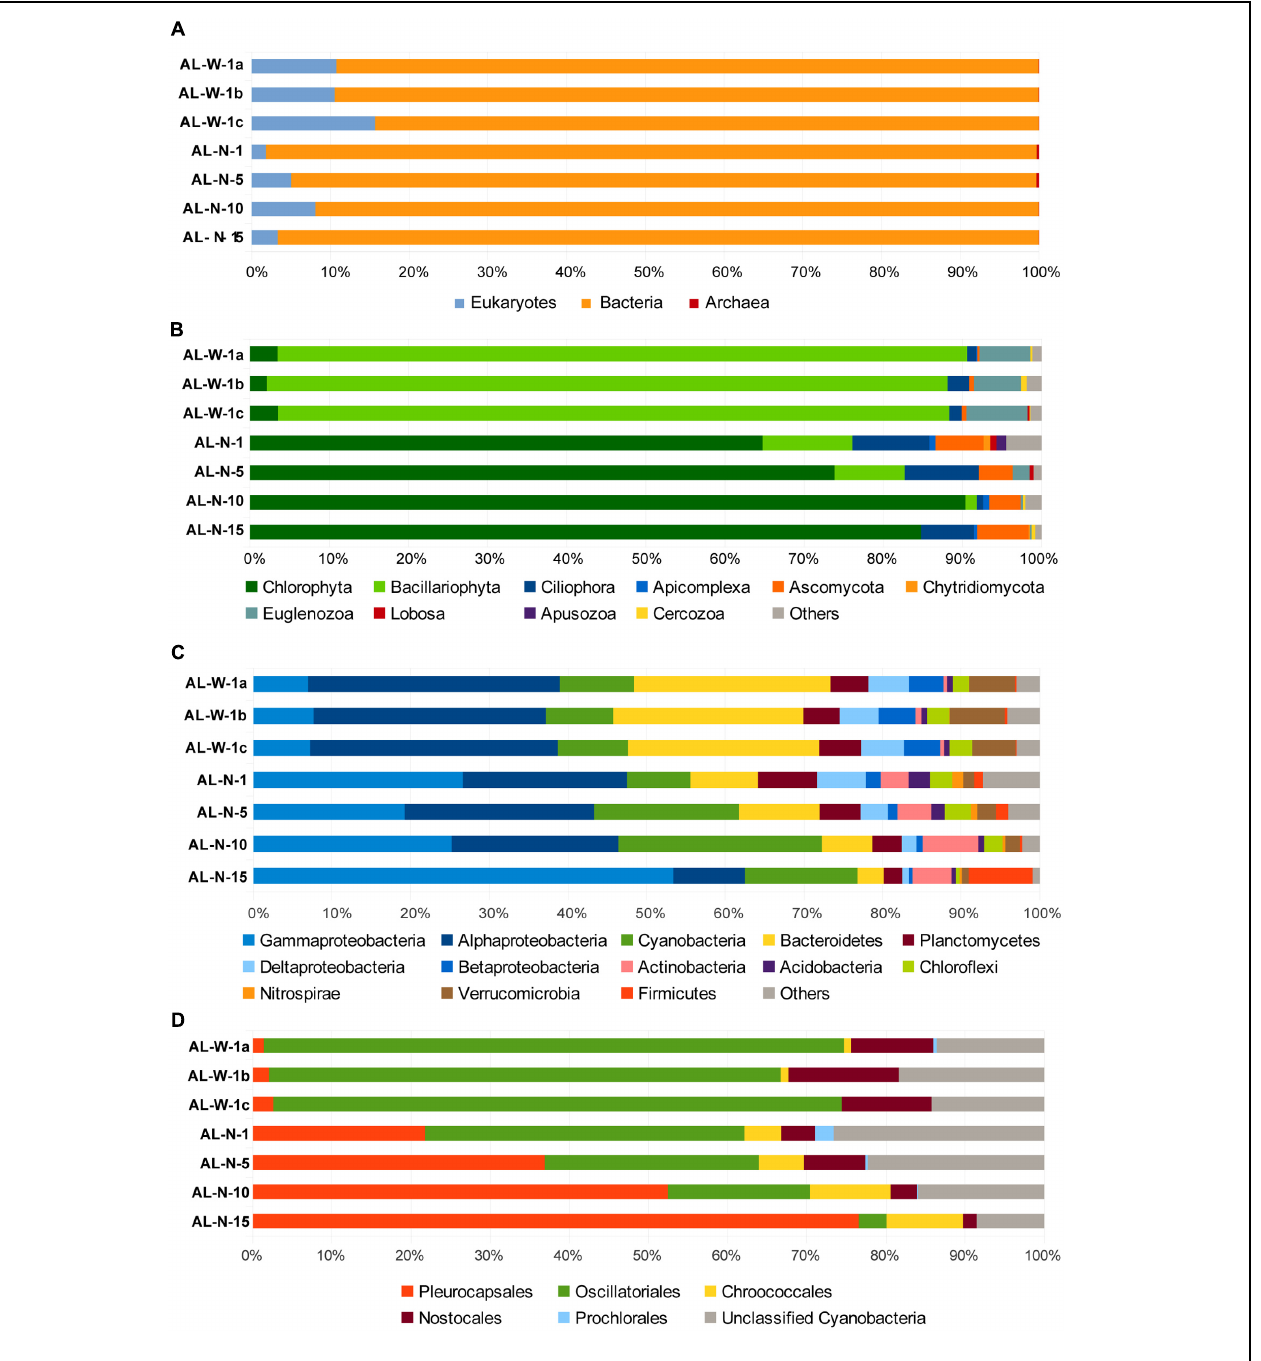
FIGURE 3 | Histograms showing the relative abundance of 16S/18S rRNA gene sequences in Alchichica microbialite metagenomes assigned to major different high-rank taxa. (A) Proportion of sequences assigned to the three domains of life: archaea, bacteria and eukaryotes to the exclusions of